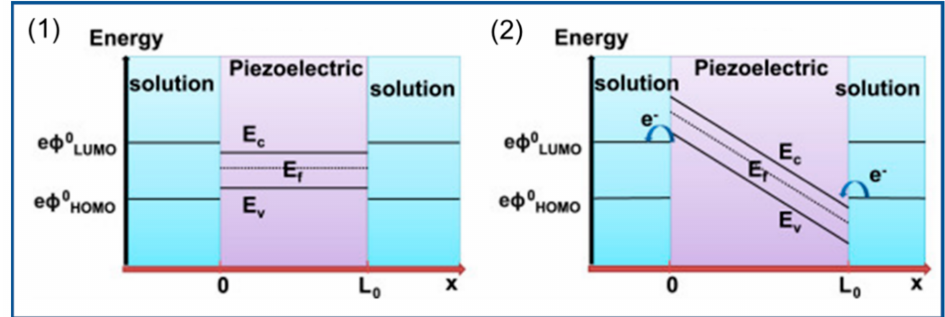
Figure 14. Band-structure changes before ( 1 ) and after ( 2 ) strain, and the energy shift on the occupied and unoccupied states. Reprinted with permission from Ref. [191], copyright 2015,